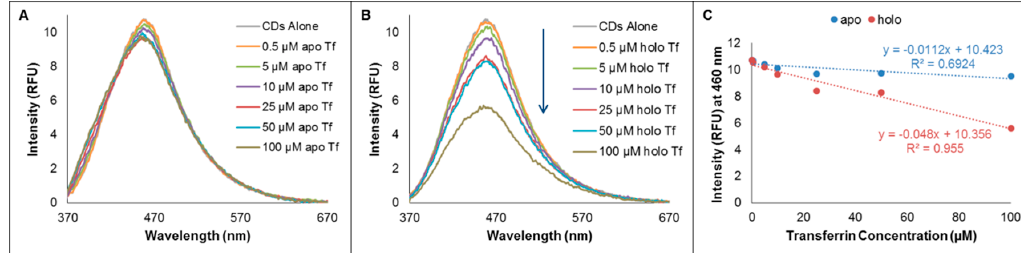
Figure 1. Fluorescence emission spectra for 35 µg/mL samples of oven-synthesized citric acid CDs, with increasing concentrations (from 0.5 µM to 100 µM) of added apo-Tf ( A ) and holo-Tf ( B ). Fluorescence response in terms of intensity at the wavelength of maximum emission (460 nm) as a function of Tf concentration, for apo- and holo-Tf are shown in ( C ). All samples were prepared to the concentrations indicated in the Figures using 50 mM tris-200 mM tricine (pH 7.4) buffer as diluent. The data were corrected for the respective native Tf fluorescence at each concentration. The excitation wavelength was 360 nm and the emission scan range was 365–700 nm.